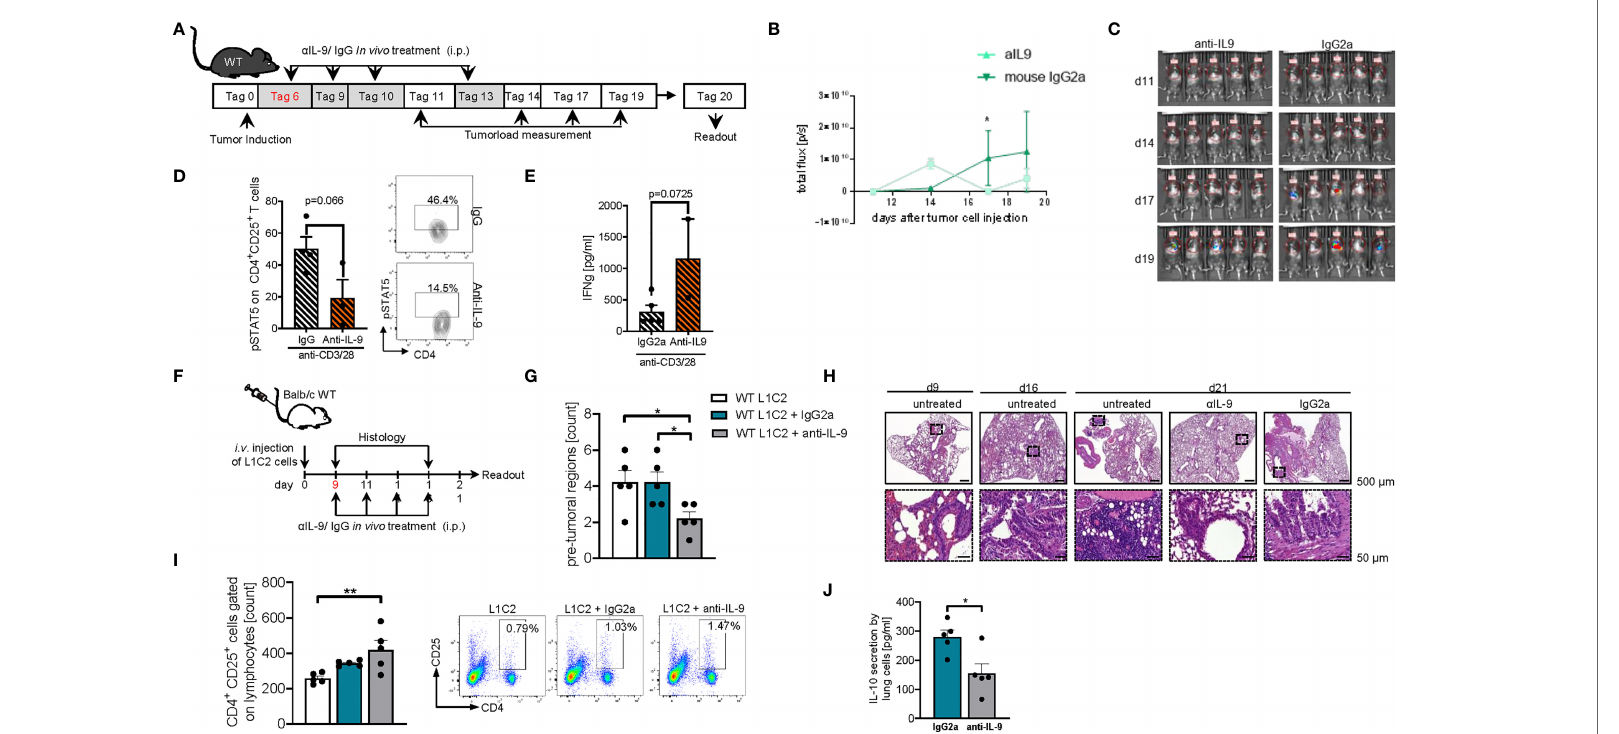
FIGURE 9 | Later treatment with anti-IL9 antibodies during tumor development, protected from experimental induced tumor. (A) Experimental design: BL/6 WT mice were intravenously injected with LL/2 cells on day 0. Mice were then treated intraperitoneally (i.p.) with anti ( a )-IL9 antibody or IgG2a isotype control on day 6, 9, 10 and 13 after tumor induction. The experiment ended on day 20. (B, C) Tumor load was analyzed via bioluminescence-based imaging system on the indicated days. Representative in vivo images of lung tumor load analysis at day 11, 14, 17 and 19 in WT mice treated with a IL9 antibody or IgG2a isotype control (c). (b)Quanti fi cation of lung tumor load (Total fl ux=photons/second) (Day10-20 n a IL-9+LL/2 = 5; n IgG2a+LL/2 = 5). (D) FACS analysis of lung pSTAT5+CD4+CD25+ lung cells after 24 hours culture with anti_CD3/CD28 antibodies (n- a IL-9+LL/2 = 5; n-IgG2a+LL/2 = 5). (E) ELISA analysis of IFN g levels (pg/ml) in supernatants obtained from cells isolated from the lung of wild-type (WT) lung tumor-bearing mice treated with/out anti( a )-IL9 antibody or IgG2a isotype control and cultured for 24h at 37°C (nIgG2a= 5; n a IL-9 = 5). N values are given per group. Bar charts indicate mean values ± SEM using student´s two-tailed t-test *p<0.05, **p<0.01, ***p<0.001. (F) Experimental design: Balb/c WT mice were intravenously injected with L1C2 cells on day 0. Mice were then treated intraperitoneally (i.p.) with anti ( a )-IL9 antibody or IgG2a isotype control on day 9, 11, 14 and 16 after tumor induction. Tumor load was analyzed via immune histology on the indicated days. The experiment ended on day 21. (G, H) Representative H&E staining of WT mice untreated or treated with a IL9 antibody or IgG2a isotype control on day 9, 16 and 21 (top, scale bar=500 µm; bottom, scale bar=50 µm) and quanti fi cation of the number of pre-tumoral lesions in the in the lung on day 21 ( nIgG2a = 5; n a IL-9 = 5). (I) Flow cytometry analysis of percentage of CD4+CD25+ cells gated on lymphocytes in non-treated or with a IL9 antibody or IgG2a isotype control treated mice. (J) ELISA analysis of IL-10 levels (pg/ml) in supernatant obtained from cells isolated from the lung of wild-type (WT) lung tumor-bearing mice treated with/out anti( a )-IL9 antibody cultured for 24h at 37°C (n untr. = 5; nIgG2a = 5; n a IL-9 = 5). N values are given per group. Bar charts indicate mean values ± SEM using student´s two-tailed t -test *p < 0.05, **p < 0.01, ***p <